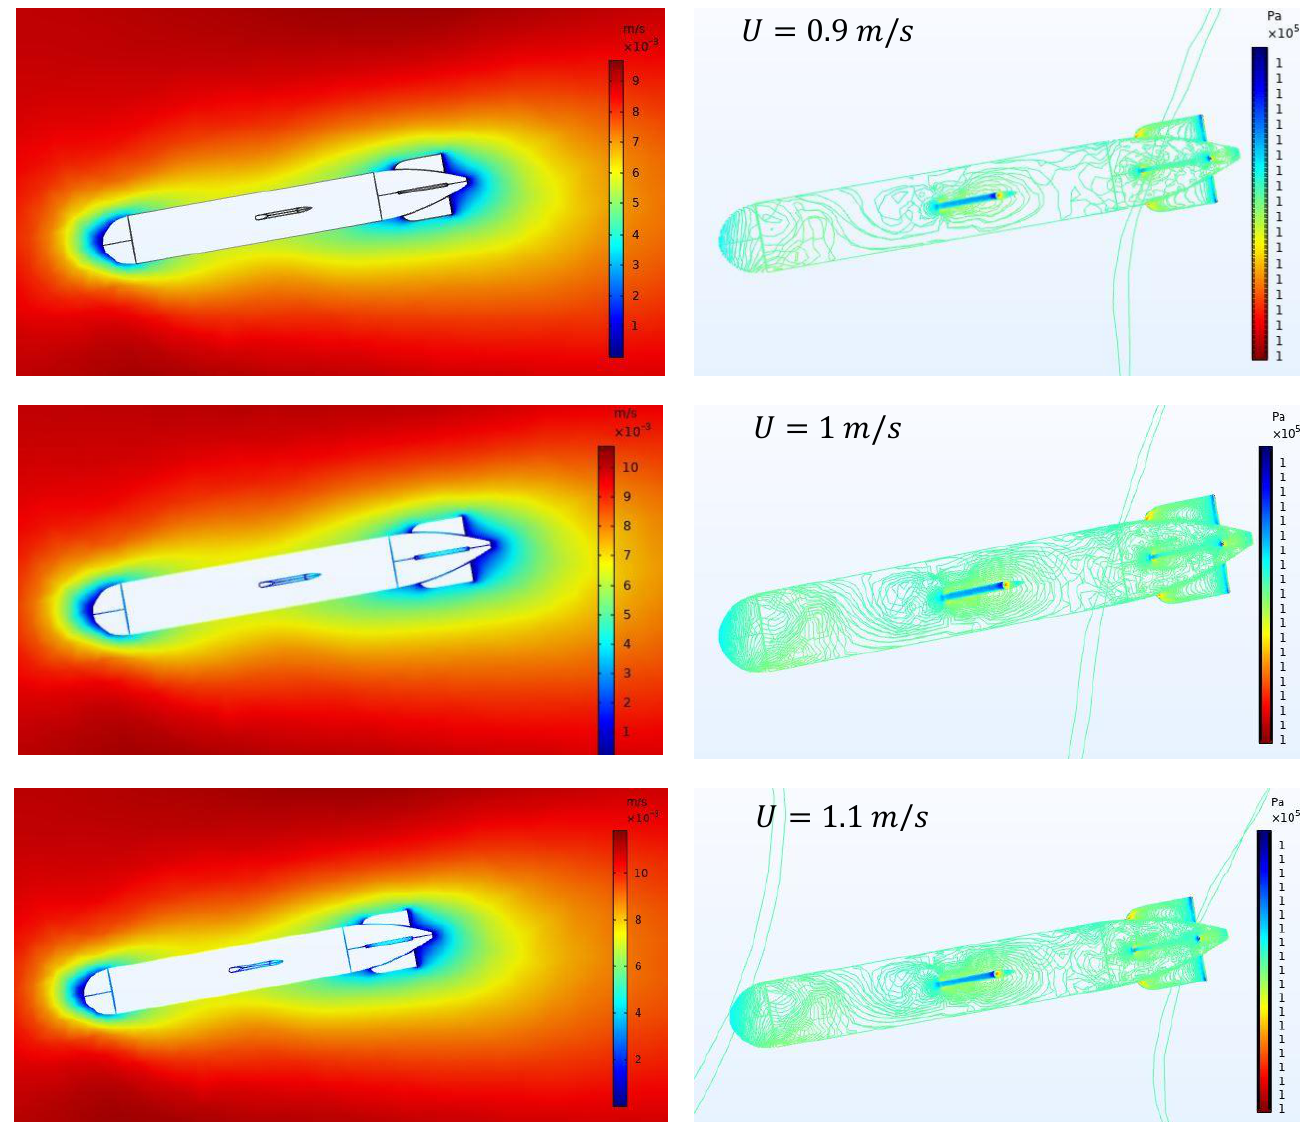
Figure 5. Velocity (left) and pressure (right) distribution with the angle of attack θ = −10 ° at different speeds of the underwater glider.